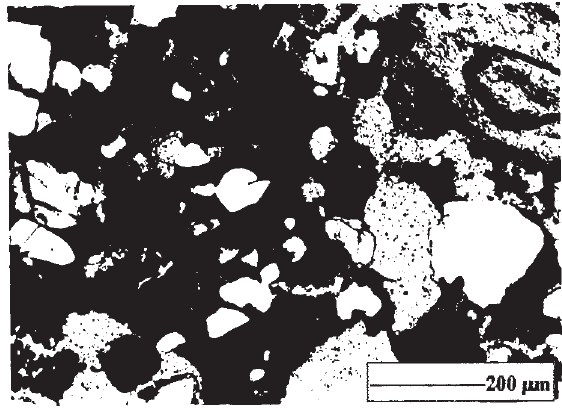
Figura 3. Contextura matricial enáulica do horizonte AB do perfil sob cultivo há dois anos (XPL).